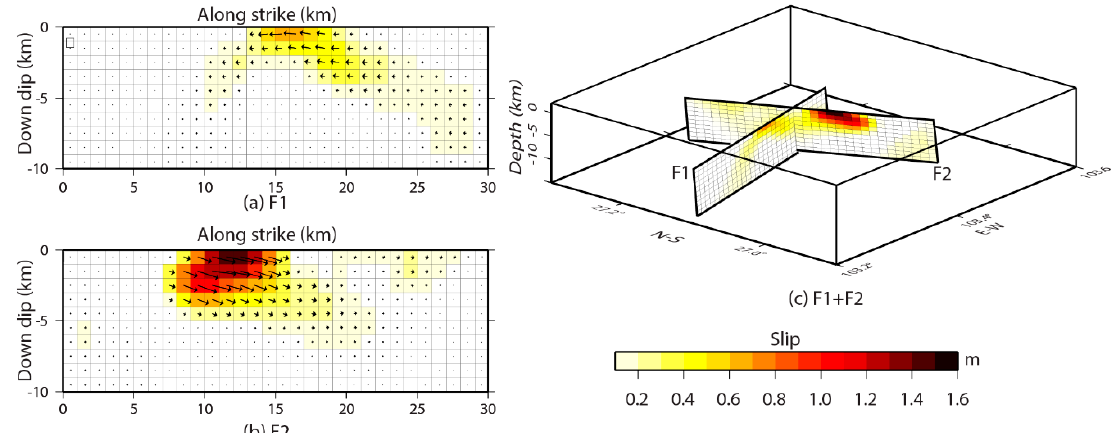
Figure 6. The optimal slip distribution for the 2014 Ludian earthquake inverted from the conjugate fault model. Slip distributions resolved ( a ) on F1 and ( b ) on F2. The black arrows show the movement direction of the hanging wall. ( c ) 3D visualization of the coseismic slip distribution.